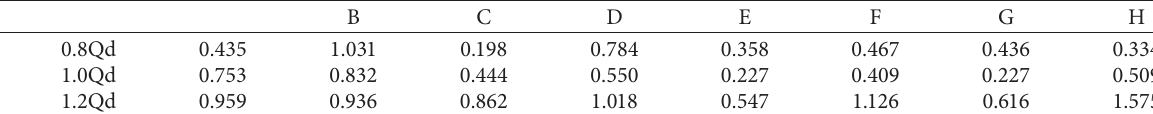
Table 5: Range analysis.